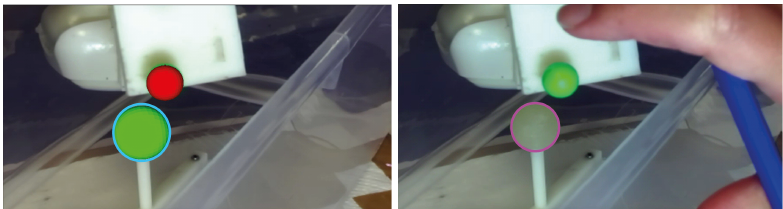
Figure 7. Example of image processing for detecting real and virtual spheres. On the ( left ), the AR image: the real scene is augmented with the virtual sphere (in green) registered over the lollipop’s head and the tracked optical frame (in red). The detected virtual sphere is represented by a blue circle. On the ( right ), the real image: the detected real lollipop’s head is represented by a magenta circle.